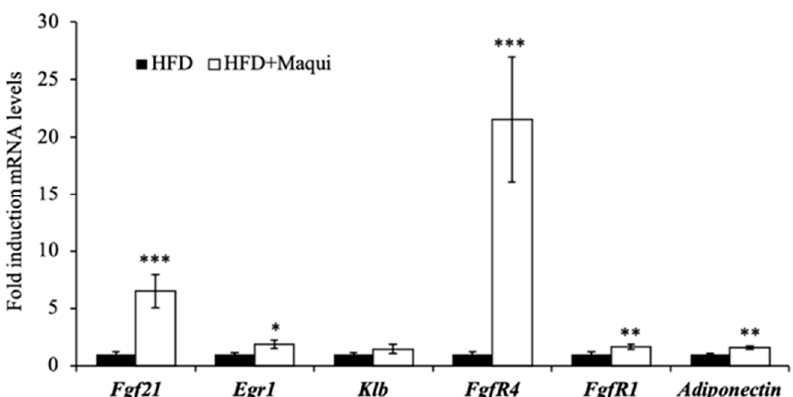
Figure 5. Maqui induces the expression of Fgf21, Fgf21 receptors and FGF21 signaling markers in scWAT. The relative mRNA levels of Fgf21, Fgf21R1, FGFR4, KLB, Adiponectin and Egr1 were measured by qRT-PCR in scWAT of HFD and HFDM mice. Bars represent the fold induction in the mRNA levels versus the HFD animals that are considered the control group and assigned an arbitrary value of 1. Data are presented as the mean ± SEM. * p < 0.05, ** p < 0.01, *** p < 0.001 versus the HFD group.